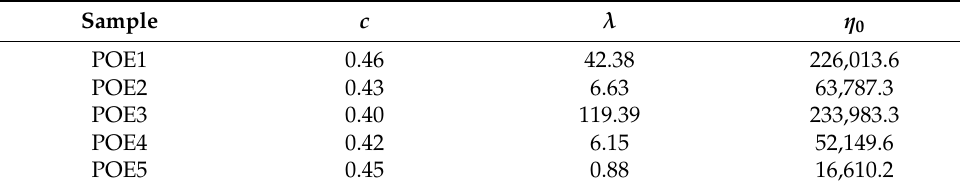
Figure 10. Expansion ratio of POE foams obtained at different temperature. The expansion ratio was measured at the aging time of 21 days. ( a ) POE samples with same MI; ( b ) POE samples with same octene content. Table 4. Rheological parameters of POE with different chain